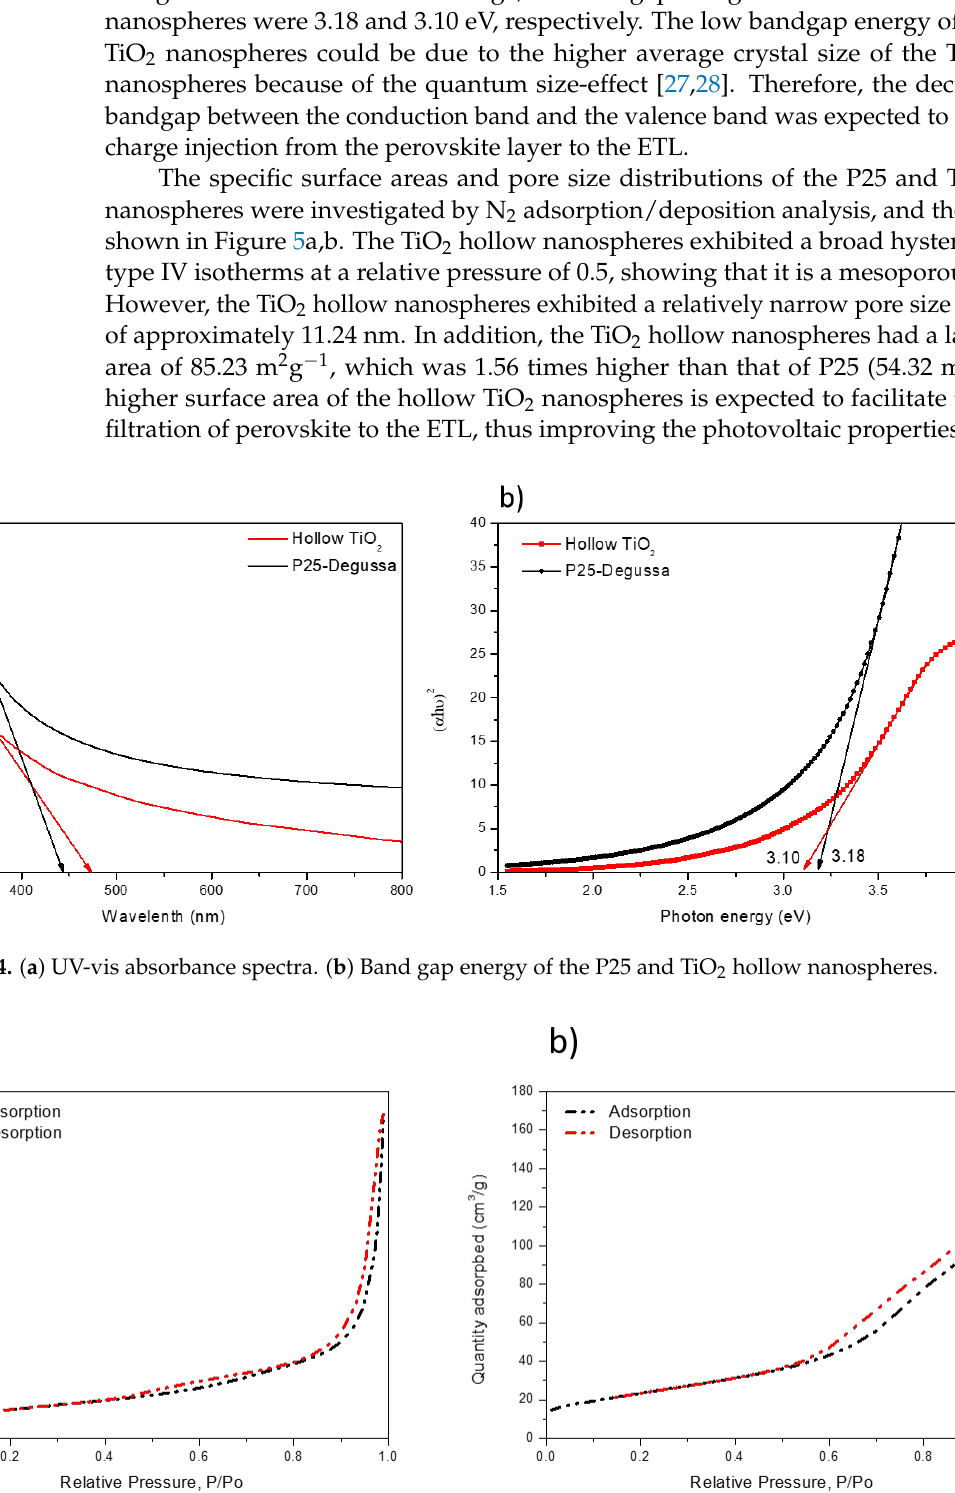
Figure 3. ( a ) FTIR of P25 powder and TiO 2 hollow powder. ( b ) XRD patterns for the P25 and TiO 2 hollow powders.